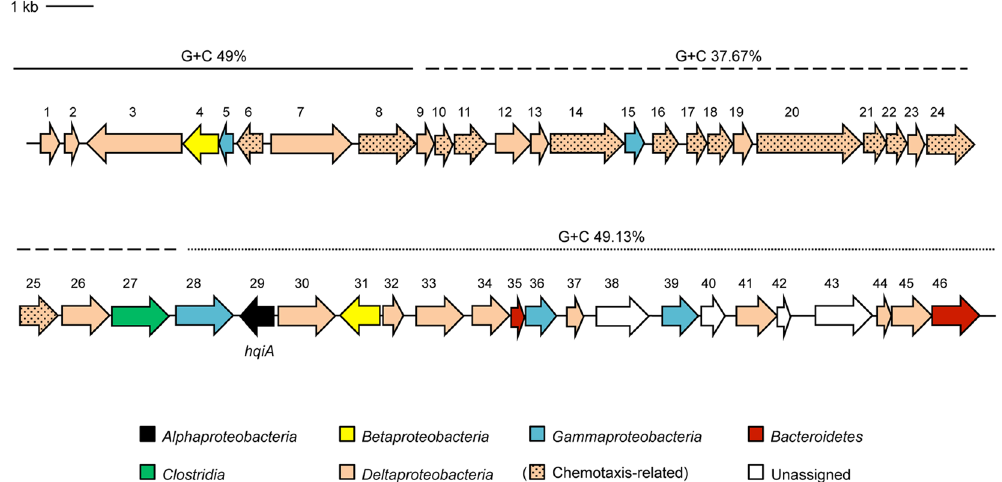
Figure 3. Genetic map of the DNA insert of the fosmid f10/17-1H. The 46 ORFs are numbered and coloured according to their phylogeny, ORF29 being (in black) hqiA . The chemotaxis related genes are also presented as square